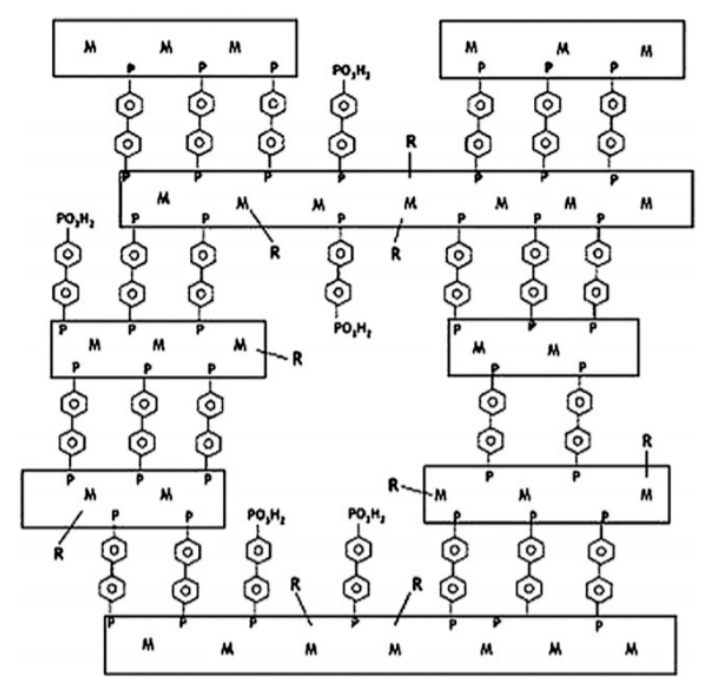
Figure 2. Schematic drawing of how micropores are formed in the metal biphenylene bis(phosphonates). The horizontal rectangles represent the inorganic layers (M = Zr or Sn) which are cross-linked by the organic moieties. R stands for F − , if HF is used in the preparation, and the surfaces are capped by M because an excess of metal is used in the syntheses. Reprinted with permission from [39]. Copyright (2009), Royal Society of Chemistry.